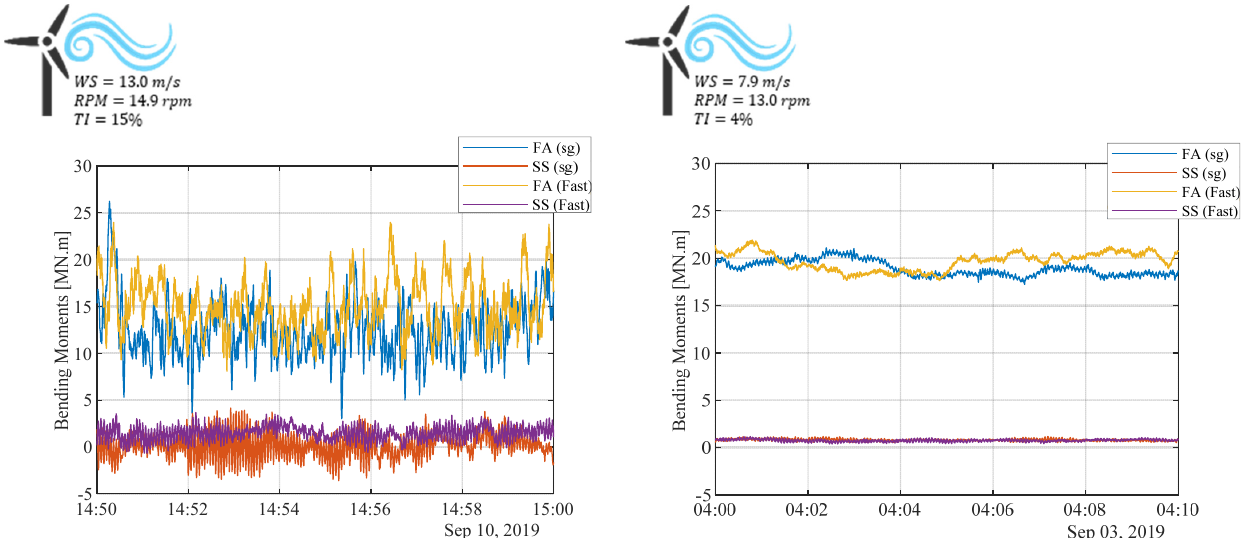
Figure 10. Experimental and numerical bending moments time series for FA and SS directions in the bottom-instrumented section of the tower considering two different operating conditions.